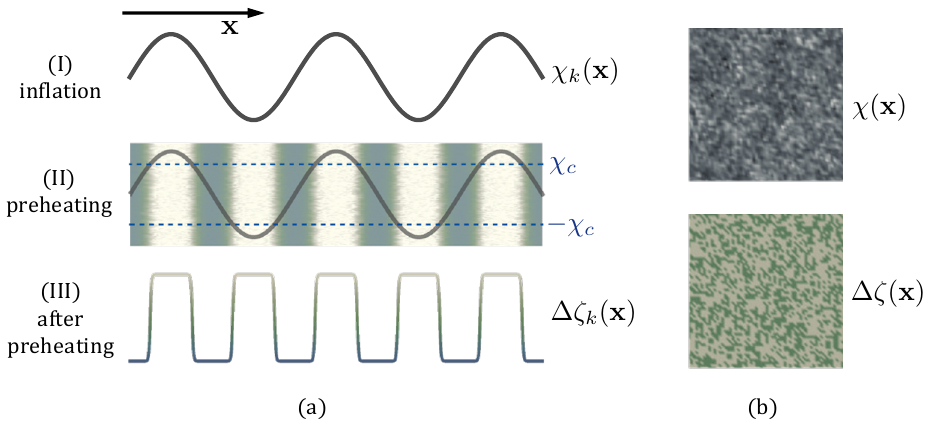
Figure 1 . Schematic picture of modulated preheating in our paper. Time flows from top to bottom. Column (a) is an illustration of the scenario with a single mode k . During inflation (I), a light scalar field χ acquires a spatially varying mode χ k ( x ) , which modulates particle production during preheating (II). Preheating is triggered only when | χ | > χ c (light yellow region), and the region with | χ | < χ c (dark green region) has negligible preheating. This then contributes a “square wave” component to the curvature perturbation ∆ ζ k ( x ) (III). Column (b) shows a scale invariant Gaussian sample of χ ( x ) and the corresponding ∆ ζ ( x ) which is also scale invariant but almost